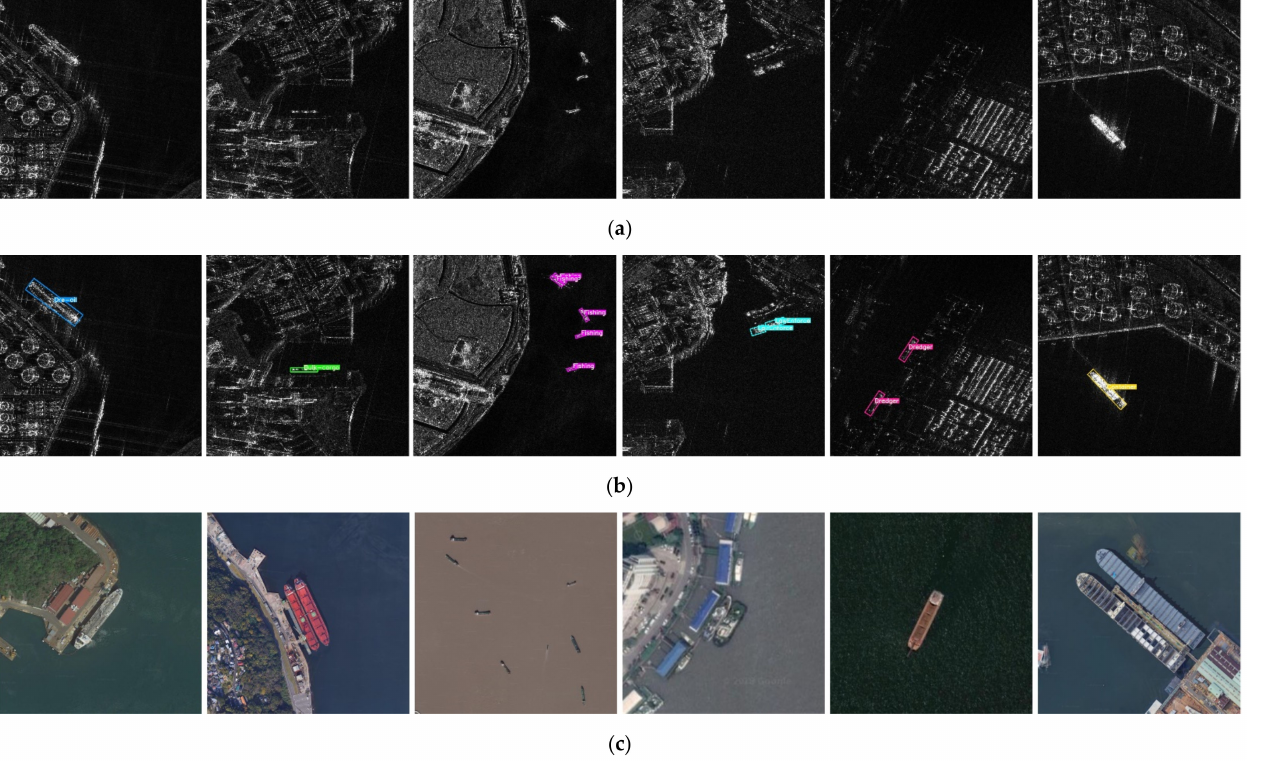
Figure 8. Instances of SRSDD-v1.0 dataset. ( a ) The original SAR images. ( b ) The ground truth. ( c ) The corresponding optical images. From left to right are the Ore-oil, Bulk cargo, Finishing, LawEnforce, Dredger, and